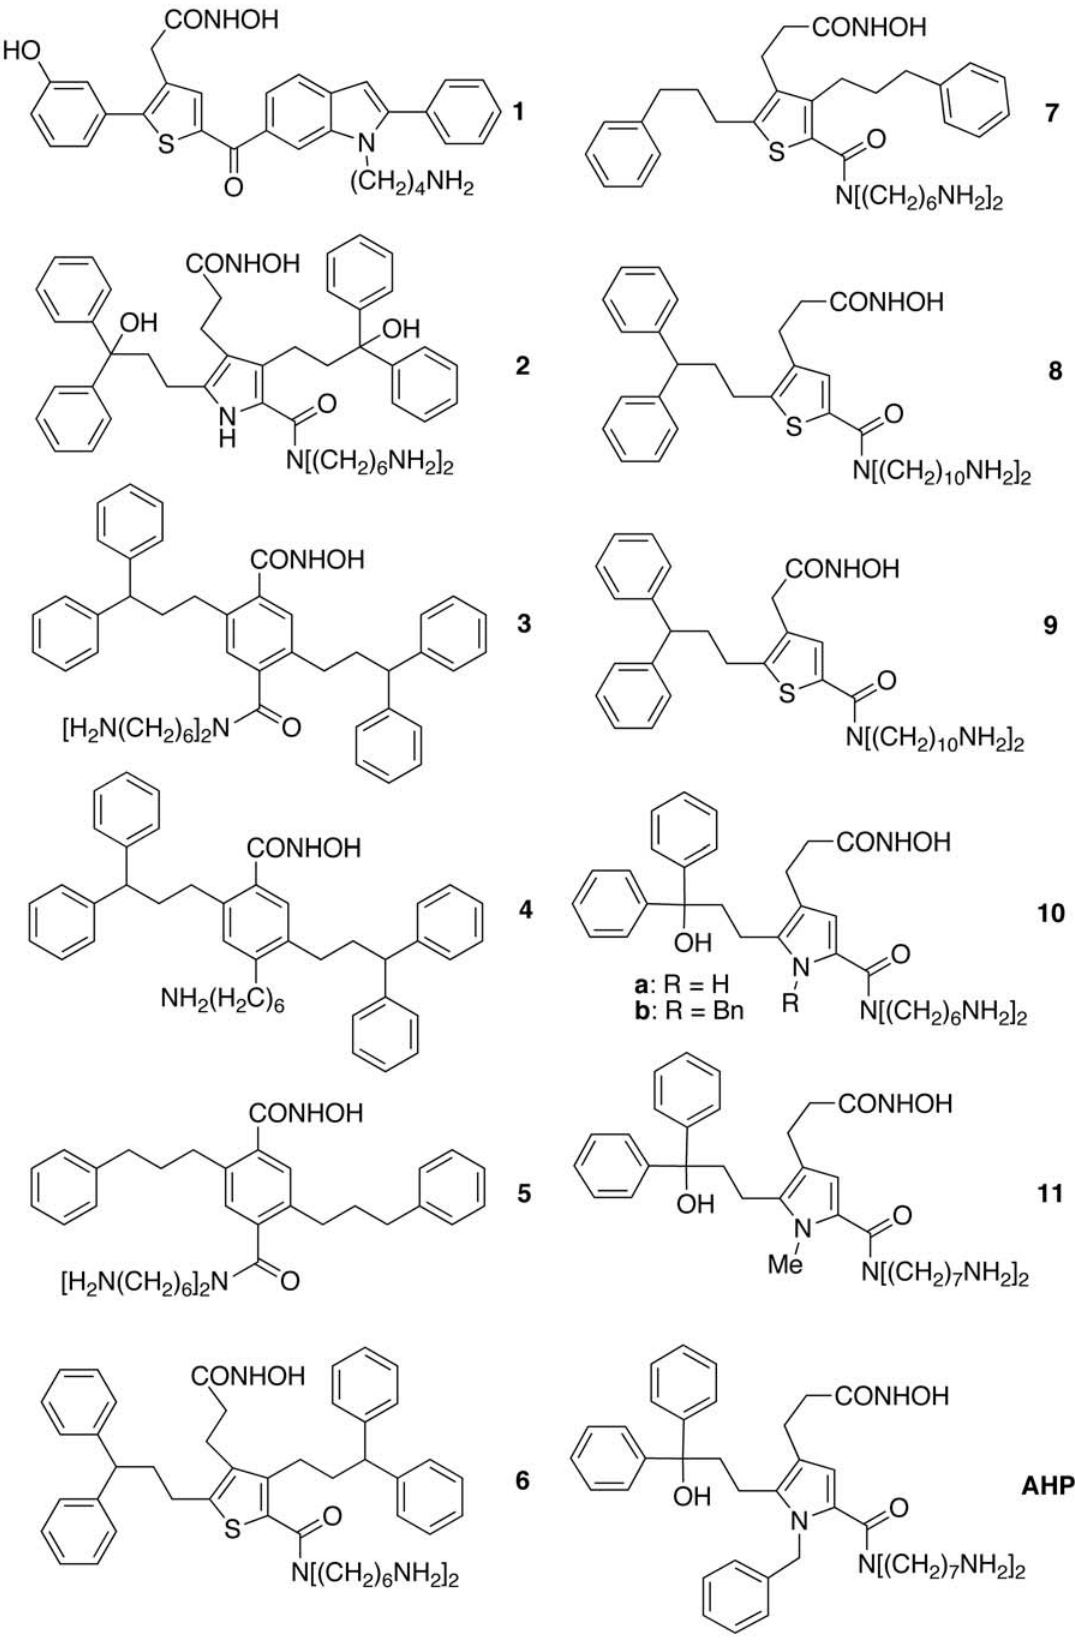
Figure 2. Chemical structures of BoNTAe inhibitors and their analogs resulted from SBCAMD.